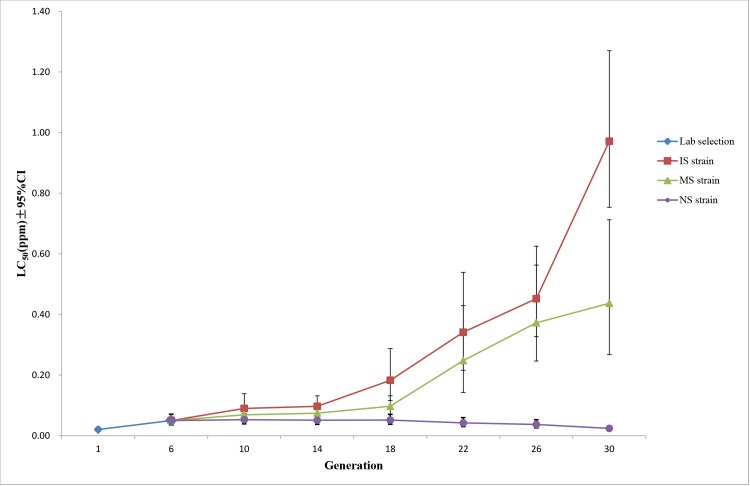
Development of larval resistance of populations under different deltamethrin selection pressures.Levels of deltamethrin resistance were dynamically monitored in three selected strains. Lab selection: the population from 1 to 6 generations were selected with insecticide together and the selection concentration was LC50 of deltamethrin for each generation. IS strain: selection concentration was LC50 of deltamethrin for each generation and resulted in 50–60% larval mortality. MS strain: selection concentration was the LC50 of deltamethrin for generation 6 (0.05 ppm), and the larval mortality was gradually decreased. NS strain: exposure to deltamethrin was withdrawn after generation 6. CI: confidence intervals.